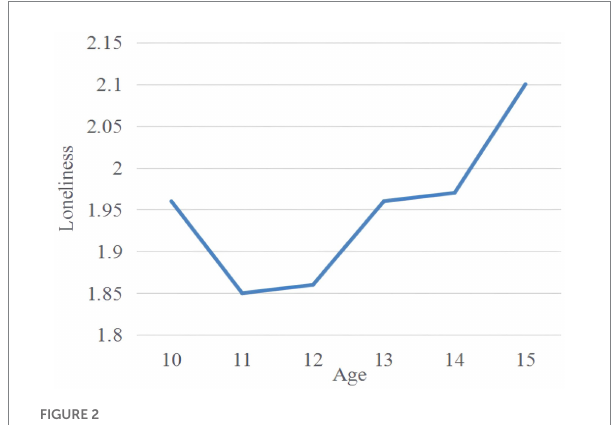
FIGURE 2 A post-test (LSD) of age differences in loneliness.